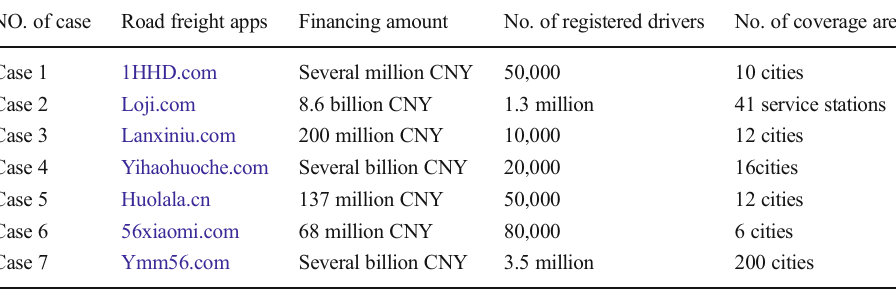
Table 4 A summary of case examples ’